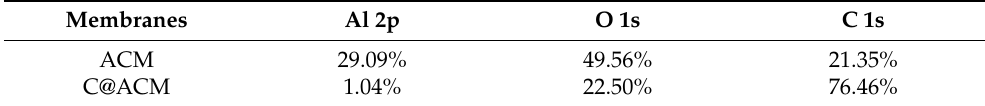
Table 2. The atomic ratio of the ceramic membrane surface was tested by XPS.